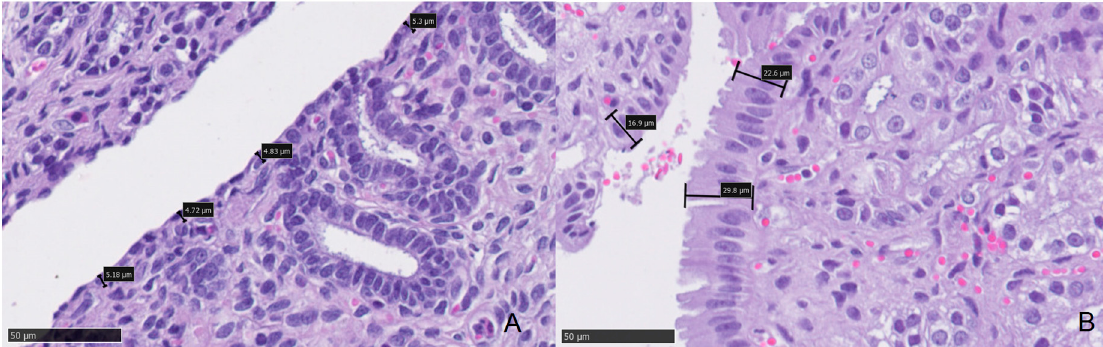
Figure 1. Epithelial height of a queen’s endometrium. ( A ) Endometrial biopsy from a queen with low levels of serum progesterone (1.4 ng/mL). Measurements obtained in the luminal epithelium of the endometrium ranged from 4.72 to 5.3 mm (black bars and boxes). ( B ) Endometrial biopsy from a queen with high levels of serum progesterone (7.7 ng/mL). Measurements obtained in the luminal epithelium of the endometrium ranged from 16.9 to 29.8 mm (black bars and boxes). Endometrial epithelial height was significantly higher in queens with high levels of serum progesterone.